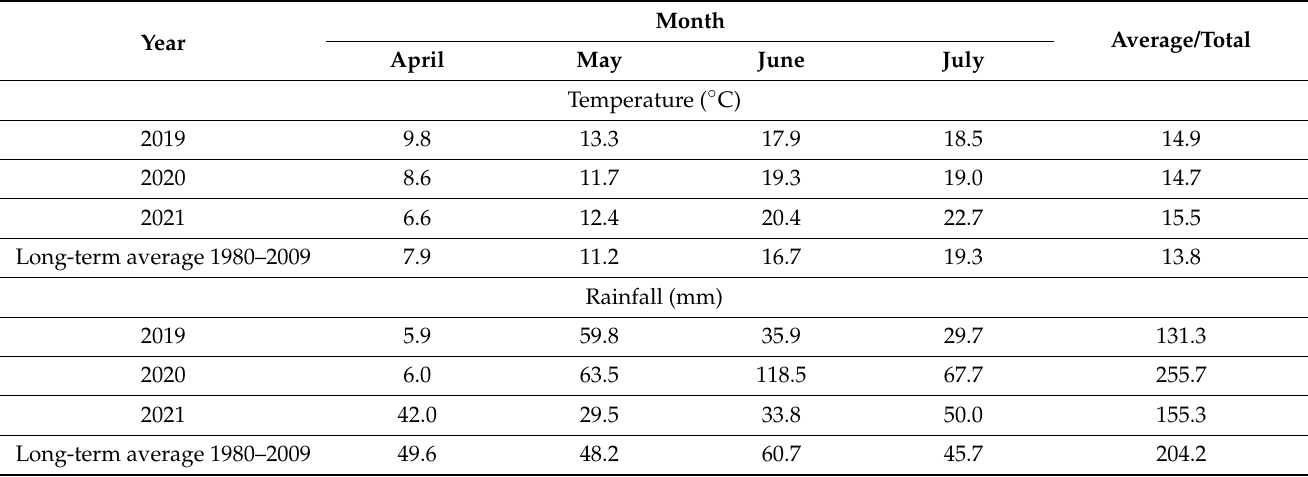
Table 1. The temperature and rainfall during the growing season of spring barley according to the Weather Station in Zawady,